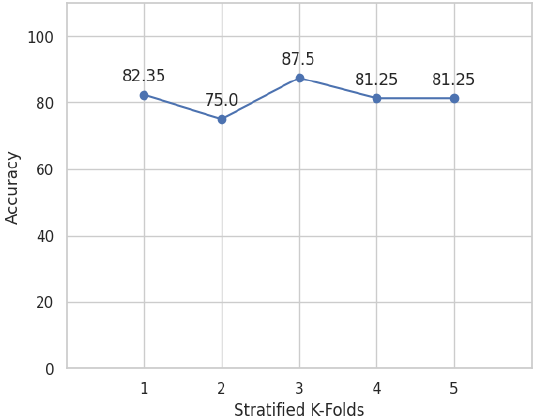
Figure 2. The classification accuracies of the LR model using the stratified five-fold cross-validation.